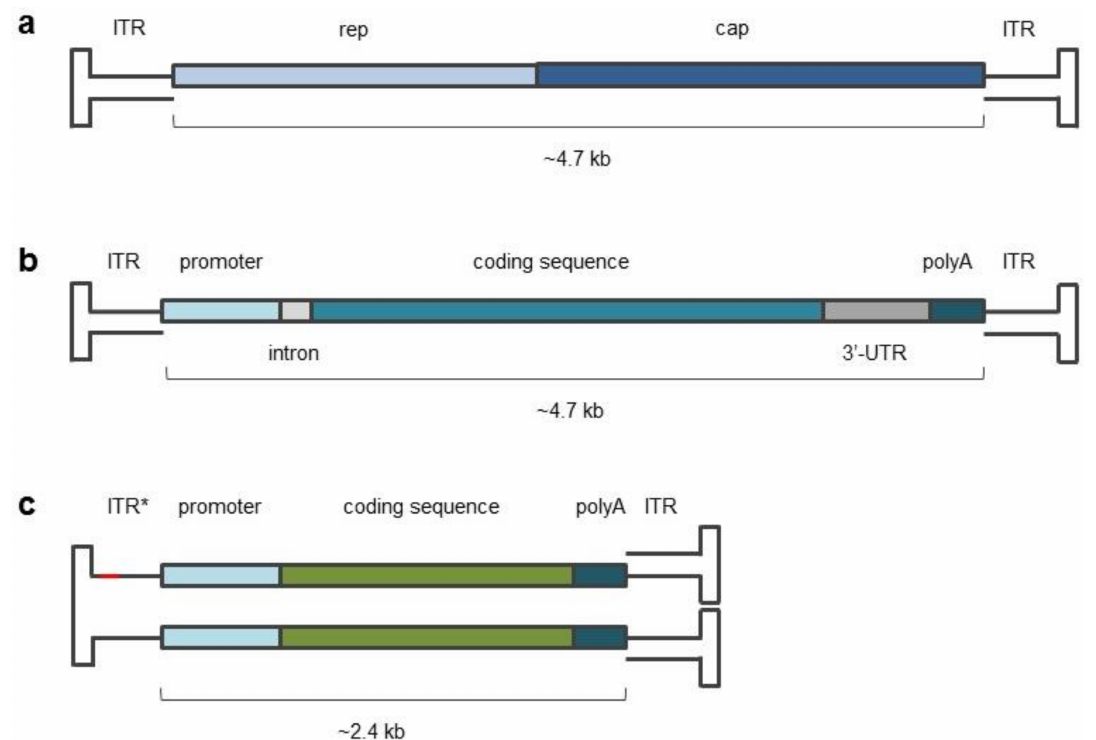
Figure 1. Structure of wild-type and vector AAV genomes. ( a ) Map of the wild-type genome, surrounded by inverted terminal repeats (ITR). ( b ) Map of a typical recombinant AAV vector genome, showing replacement of the viral rep and cap genes with a transgene cassette. ( c ) Map of a self- complementary recombinant AAV vector, forming a double-stranded structure due to presence of forward and reverse complement transgene sequences along with one mutated ITR (ITR